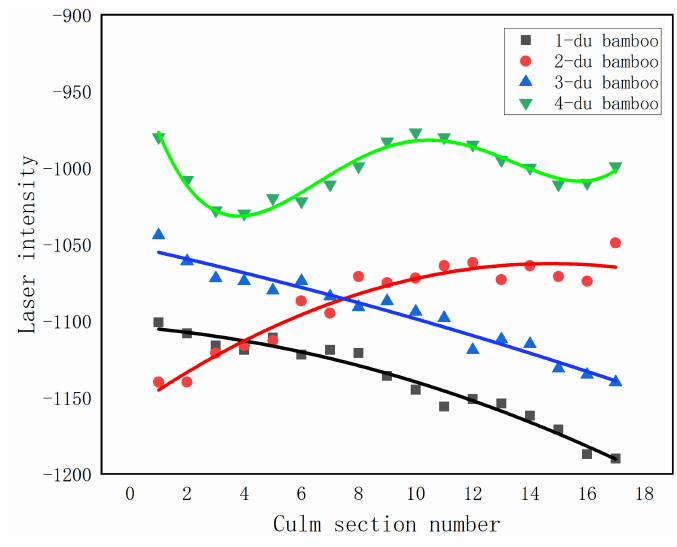
Figure 8. Polynomial fitting results for different bamboo